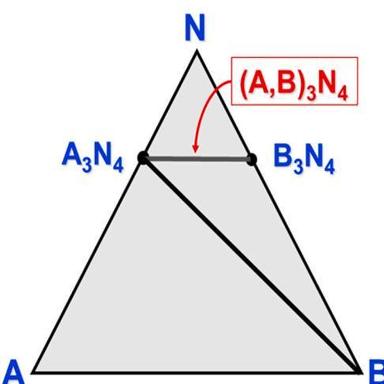
Thermodynamic guideline for the synthesis of nitrides of the form A3N4 and B3N4 and their solid solutions (A,B)3N4 with i) A, B = C, Si, Ge, Sn (spinelnitrides) and ii) A, B = Ti, Zr, Hf with Th3P4-type structure.